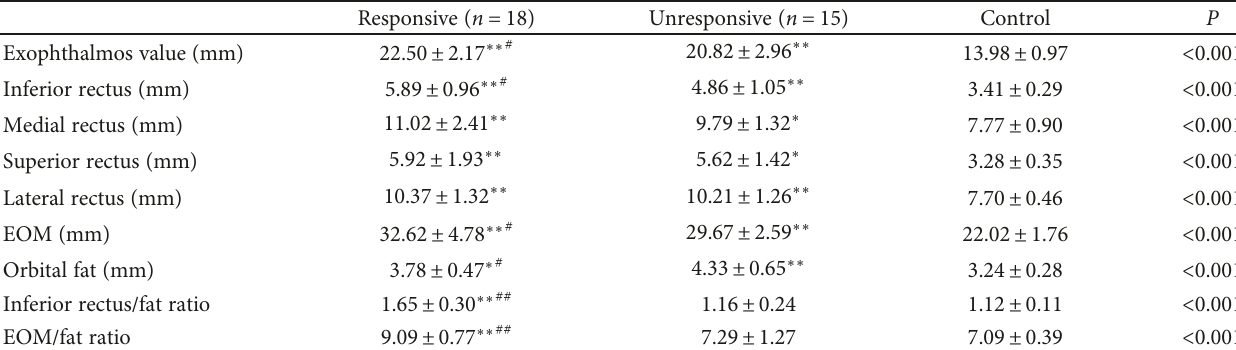
Table 2: Comparison of ophthalmic parameter measurement in